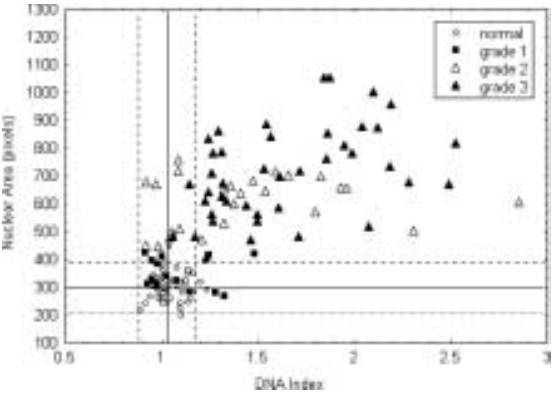
Fig. 1. Mean nuclear area vs mean DNA index in breast carcinoma specimens. The open circles in the diploid range represent normal epithelial cell measurements combined from all biopsies. 95% con- fidence bands (dashed lines) for the estimation of the means (solid line) are shown for normal cells (open